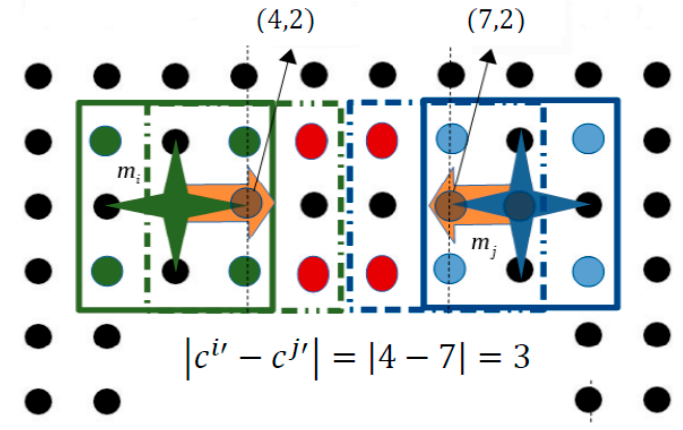
Micromachines 2018 , 9 , x FOR PEER REVIEW Figure 17. Collision due to wrong simultaneous activations. Figure 17. Collision due to wrong simultaneous activations.